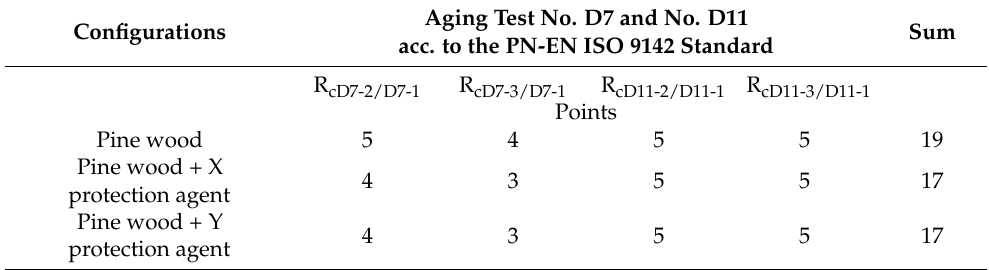
Table 9. Point scores for criterion for aging tests (acc. to Table